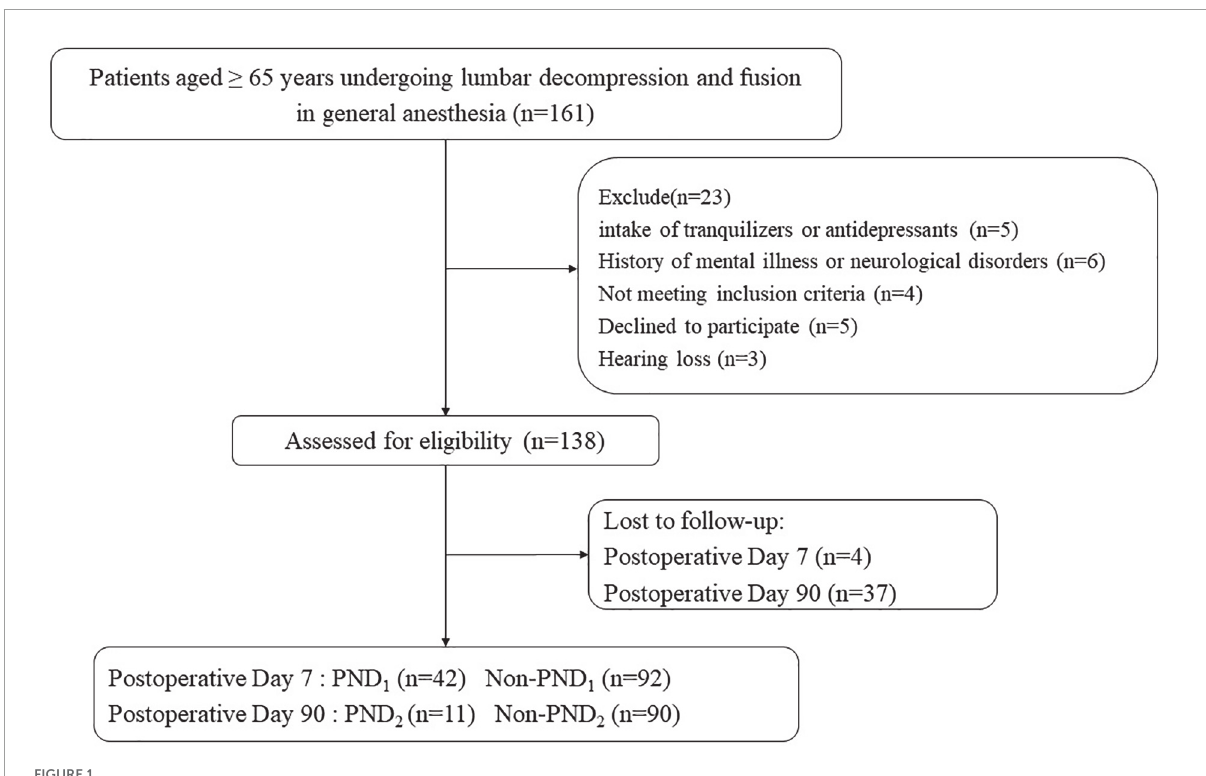
FIGURE1 The CONSORT diagram showing patients’ flow through the study.